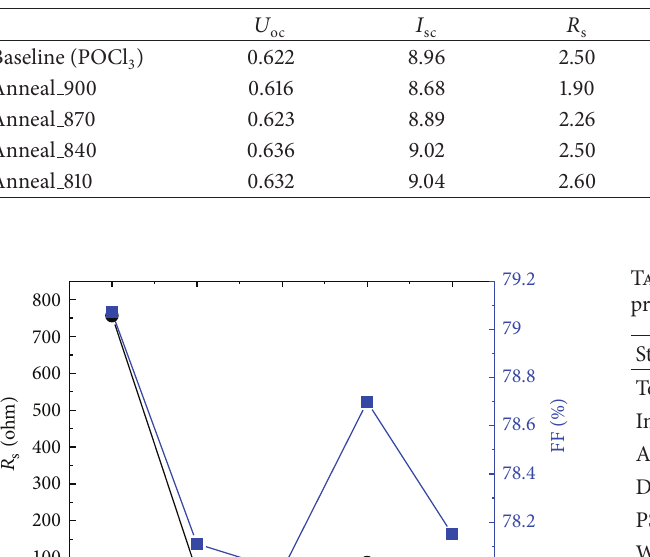
diffusion and implantation processes. 3